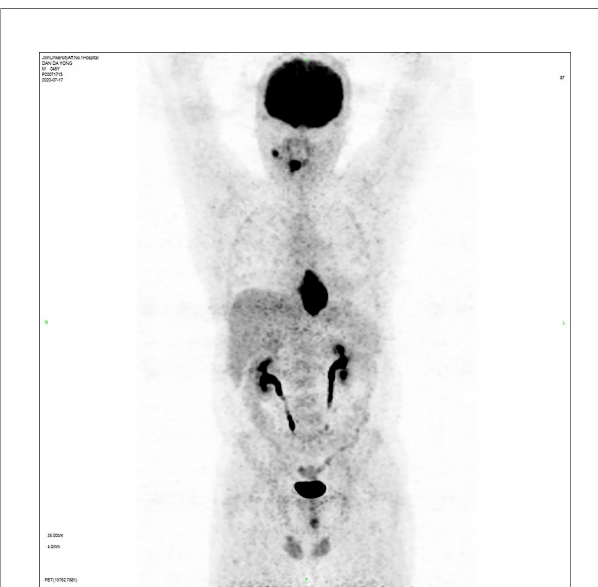
FIGURE 5 | Hematoxylin-eosin stained section of hypopharyngeal invasive squamous cell carcinoma. (On July 21, 2020, a tissue biopsy specimen was taken from the right hypopharynx under